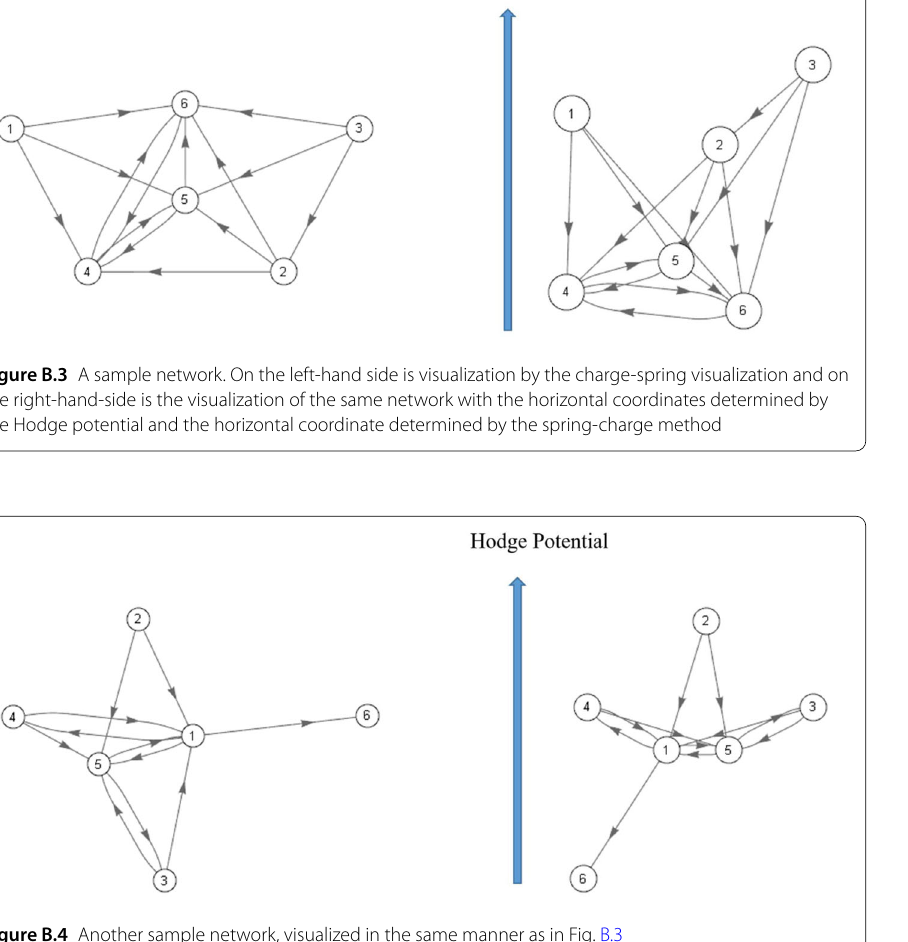
Figure B.4 Another sample network, visualized in the same manner as in Fig.